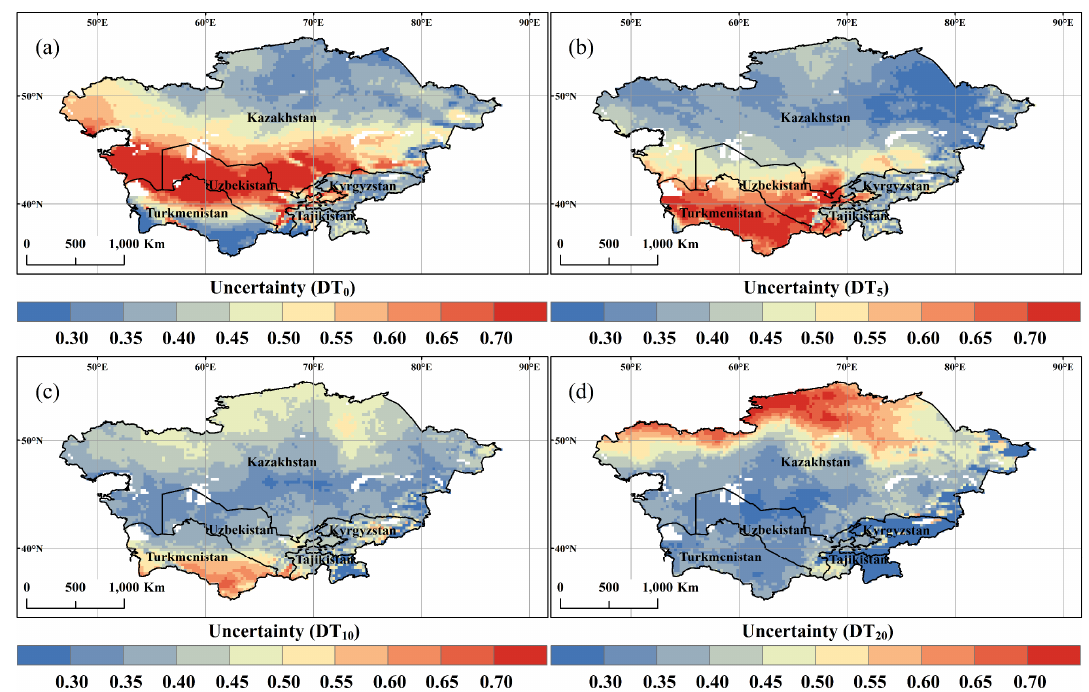
Figure 7. Spatial distribution of uncertainty in the trends of ( a ) DT 0 , ( b ) DT 5 , ( c ) DT 10 , and ( d ) DT 20 during the period 1982–2014.